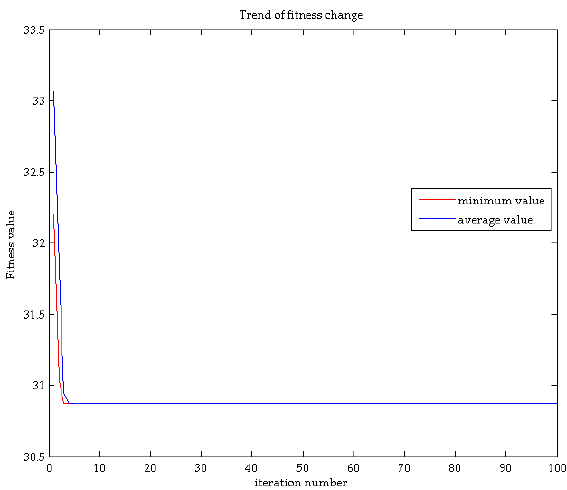
Figure 7. The trend of the adaptation value of the shortest charging time.